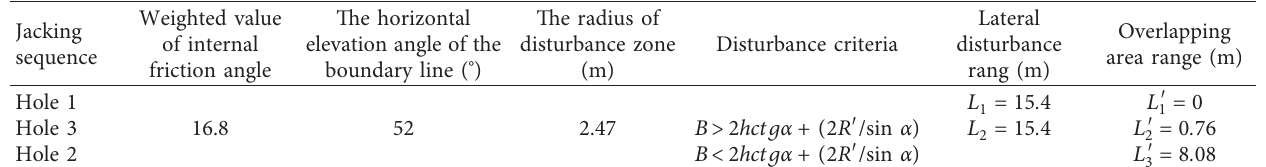
Table 2: Calculation table of lateral disturbance range and overlapping